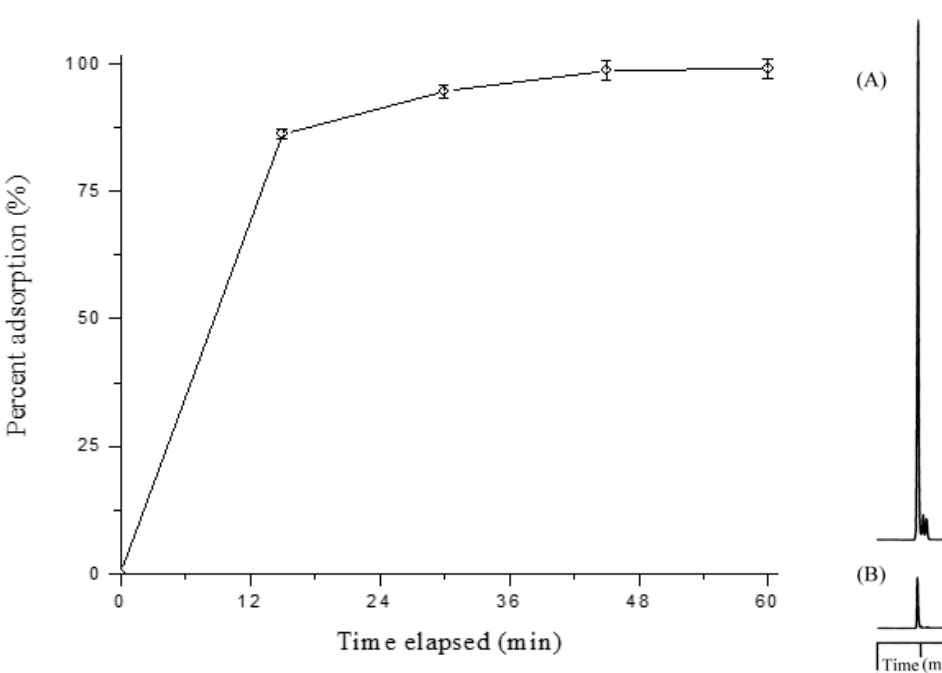
Figure 5. The relationship between the percentage of adsorption for phenylmercuric salicylate and the contact time during a 1-h process. The chromatograms show the standard ( A ), and the percentage of adsorption for 15 min contact time ( B ). The mobile phase of 491/10/1/1 by volume (acetonitrile/methanol/acetic acid/triethylamine, v / v ) was used in the evaluation. The UV detection wavelength was set at 259 nm.